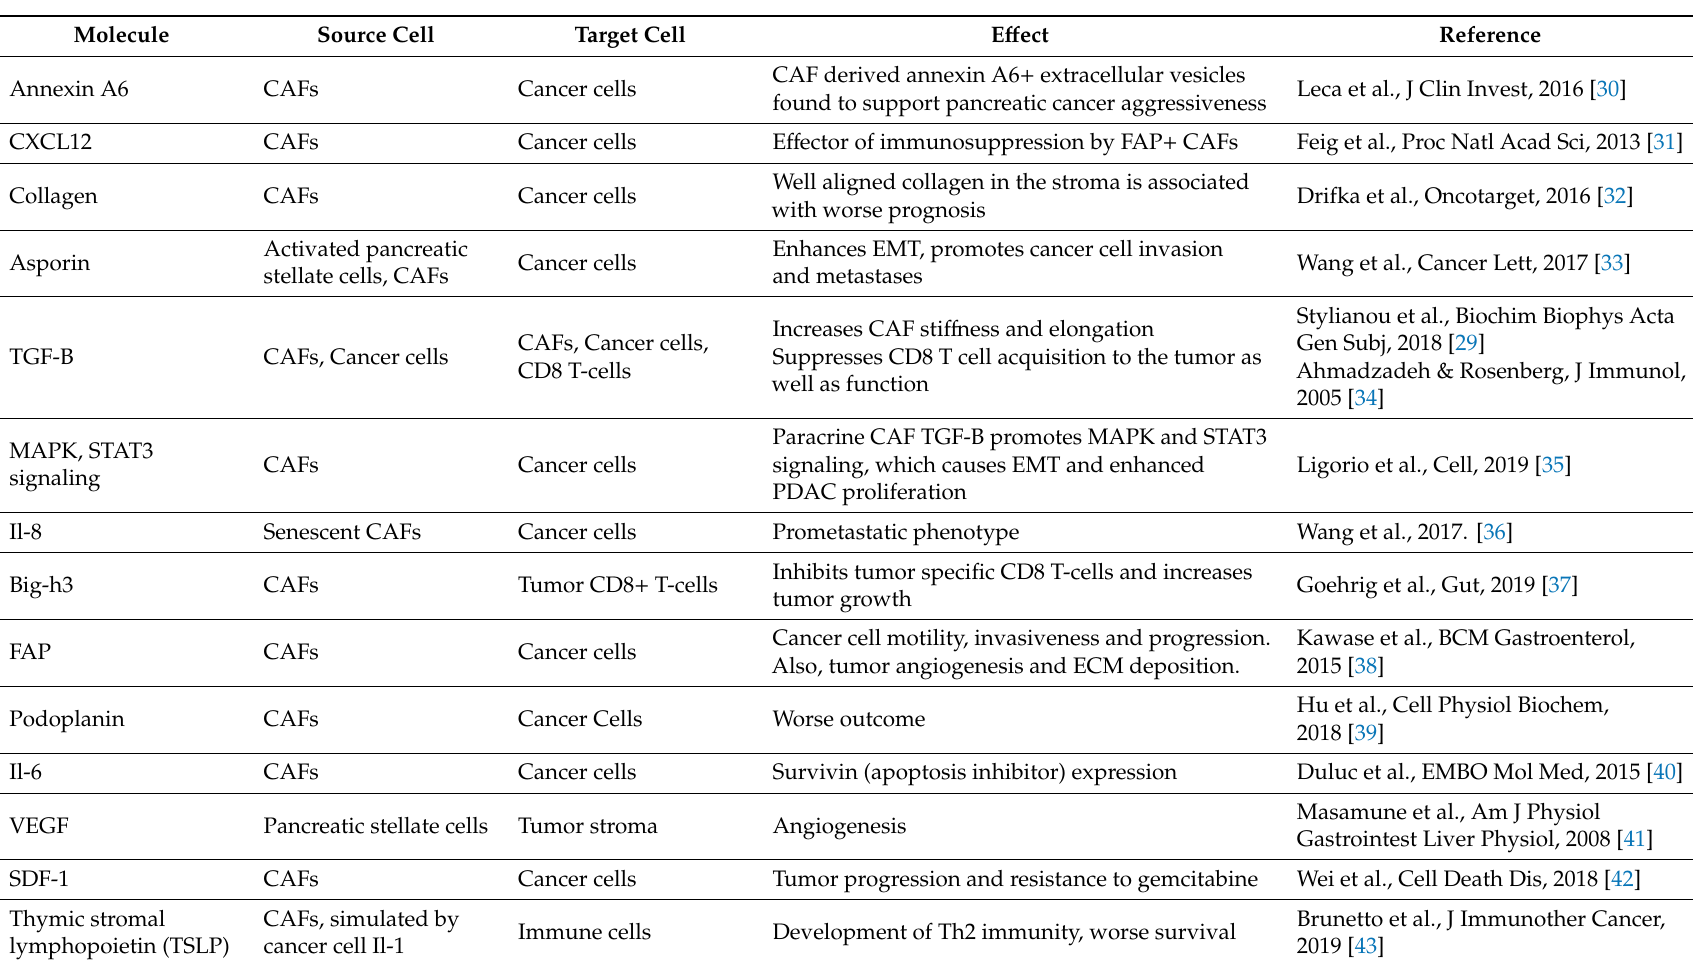
Table 1. Cancer associated fibroblasts (CAFs) play a central role in the multistep processes of tumor initiation, progression, invasion, and